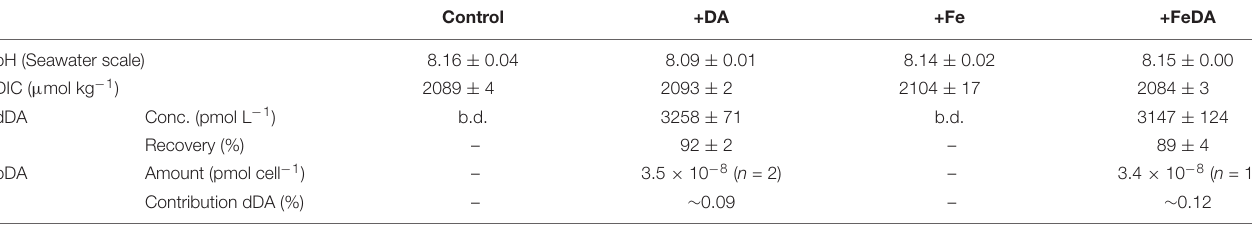
TABLE 2 | P. subcurvata grown under absence/addition of dissolved iron (Fe) and domoic acid (DA), respectively.